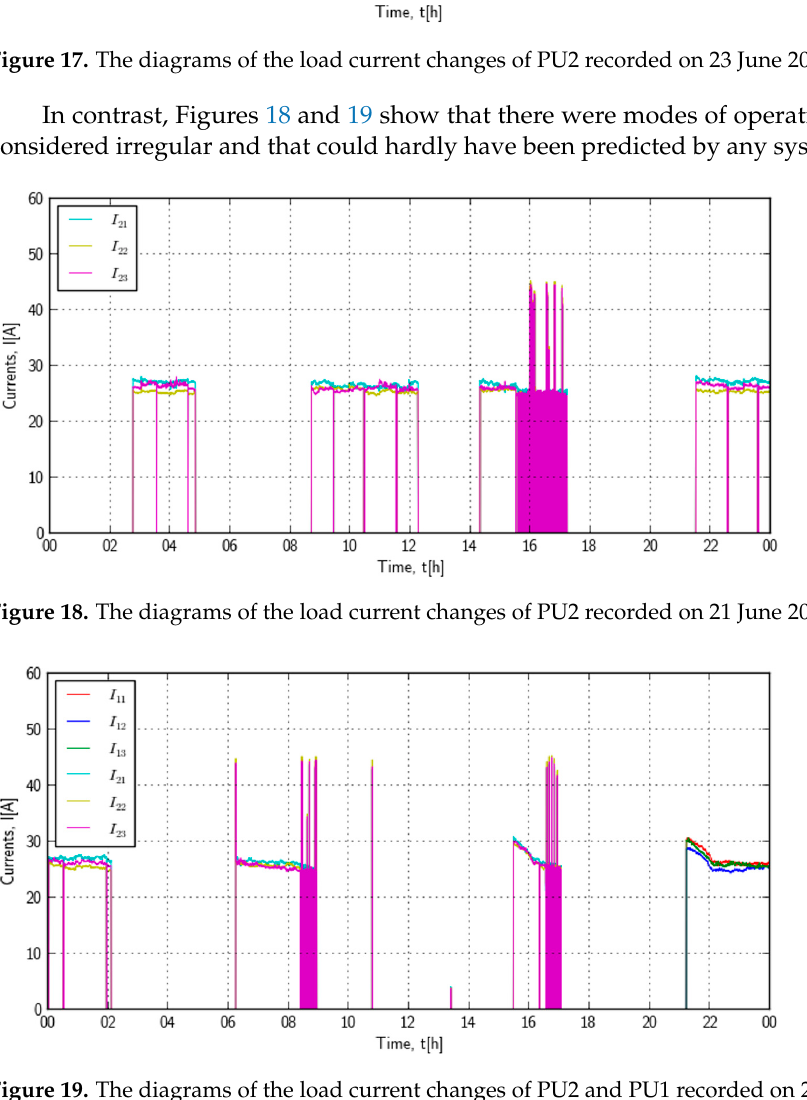
Figure 17. The diagrams of the load current changes of PU2 recorded on 23 June 2009.